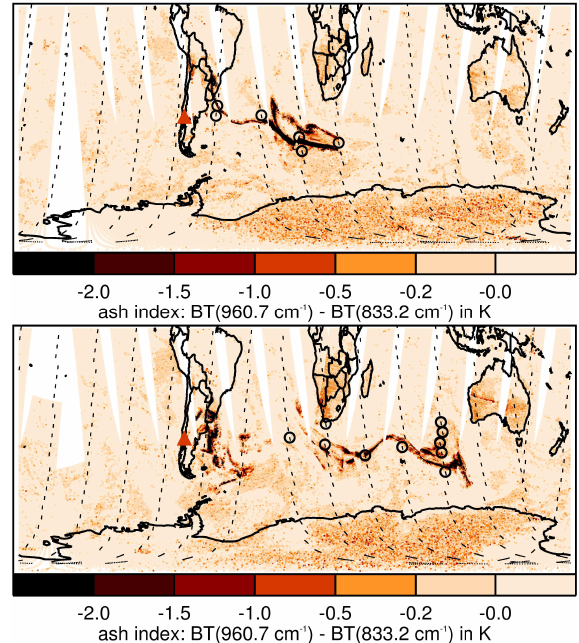
Fig. 7. MIPAS and AIRS volcanic ash detections between 12 and 24 UTC on 07 and 09 June 2011. The AIRS ash index (brightness Figure 7. MIPAS and AIRS volcanic ash detections between temperature ( 960.7cm − 1 ) − brightnesstemperature ( 833.2cm − 1 ) )iscolourcoded.Theblackcirclesindicatetheprofileswherevolcanicash wasdetectedbyMIPAS.ThePuyehue-Cord´onCaulleismarkedbytheredtriangleandtheblackdashesdenotetheMIPAStangentpoints 12:00 and 24:00UTC on 7 and 9 June 2011. The AIRS ash in- below30km. dex (brightness temperature ( 960.7cm − 1 ) – brightness tempera- ture ( 833.2cm − 1 ) ) is colour coded. The black circles indicate the profiles where volcanic ash was detected by MIPAS. The Puyehue- Cordón Caulle is marked by the red triangle and the black dashes denote the MIPAS tangent points below